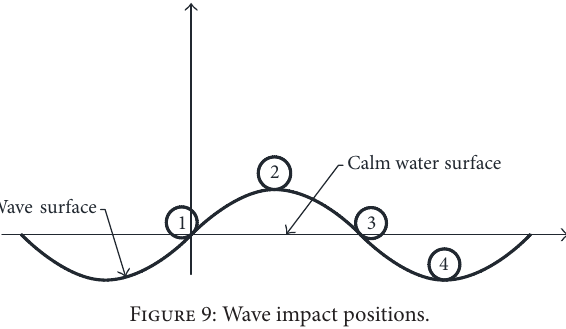
Figure 9: Wave impact positions.